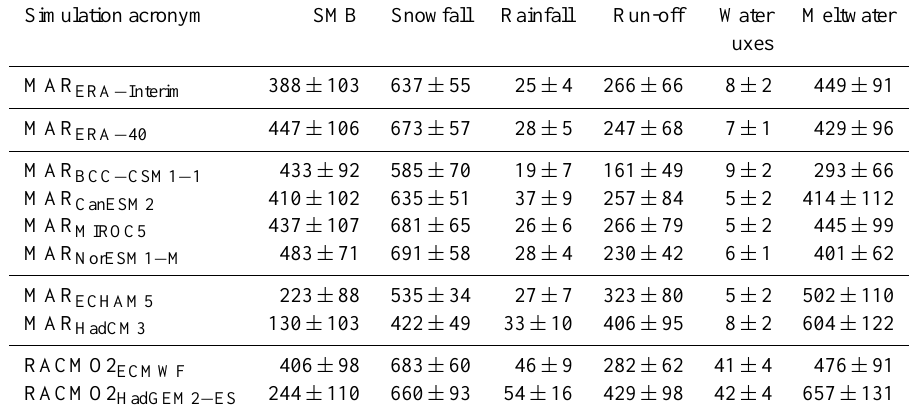
Table 2. Average and standard deviation (gauging the interannual variability) of the annual surface mass balance components simulated by MAR and RACMO2 over 1980–1999. Units are GTyr − 1 and acronym of each simulation (RCM forcings ) is given in the first column. The surface mass balance (SMB) equation here is SMB = snowfall + rainfall − run-off − water fluxes. The run-off is the part of not refrozen water from both surface melt and rainfall reaching the ocean. Simulation acronym SMB Snowfall Rainfall Run-off Water Meltwater